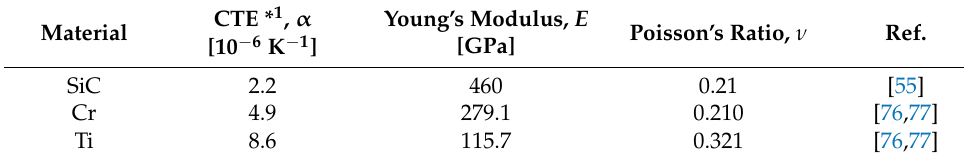
Table 4. Properties of SiC, Cr, and Ti at room temperature.